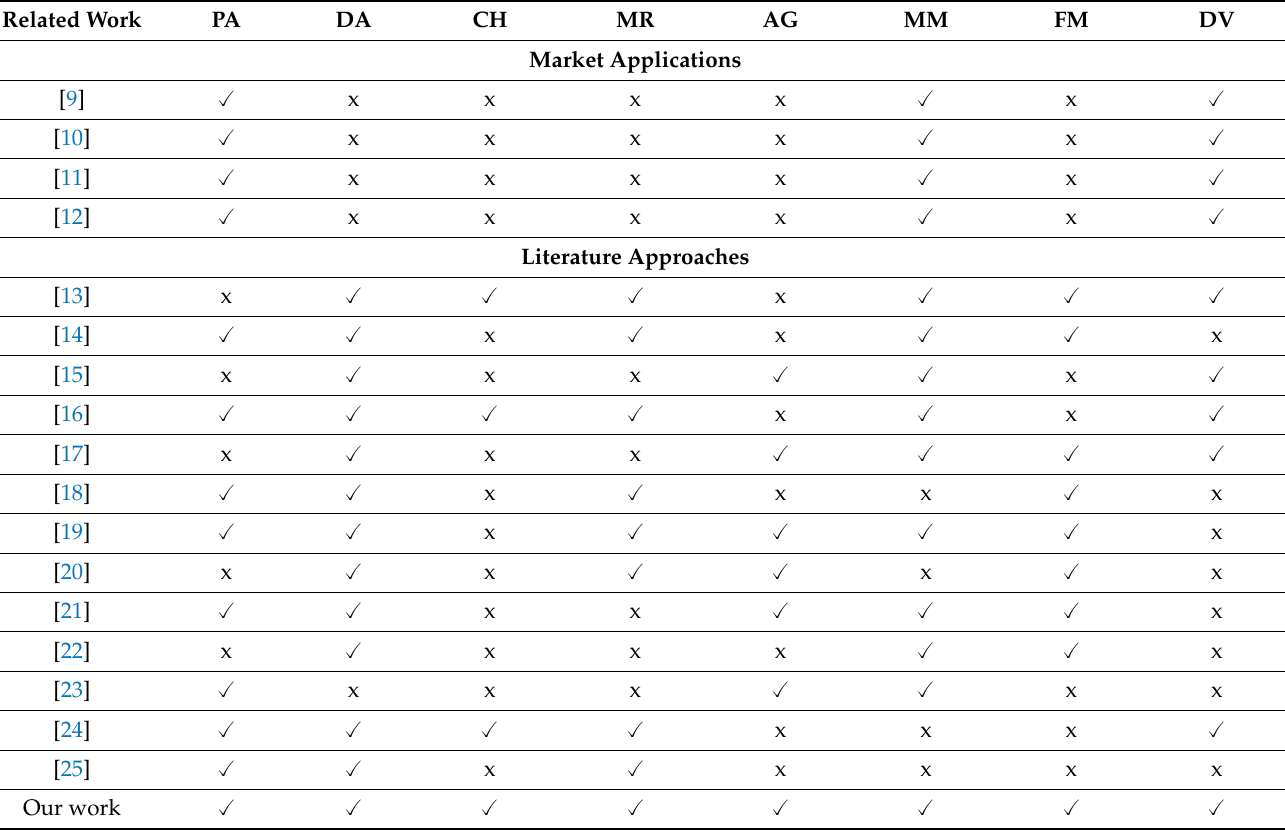
Table 1. Comparison of telemonitoring